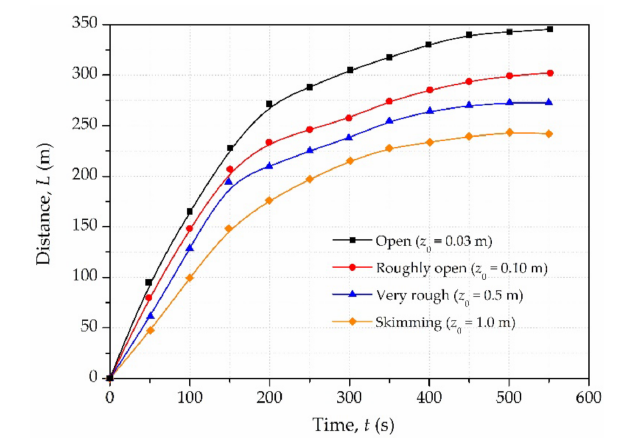
Figure 12. Distance–time history curves of different types of plant